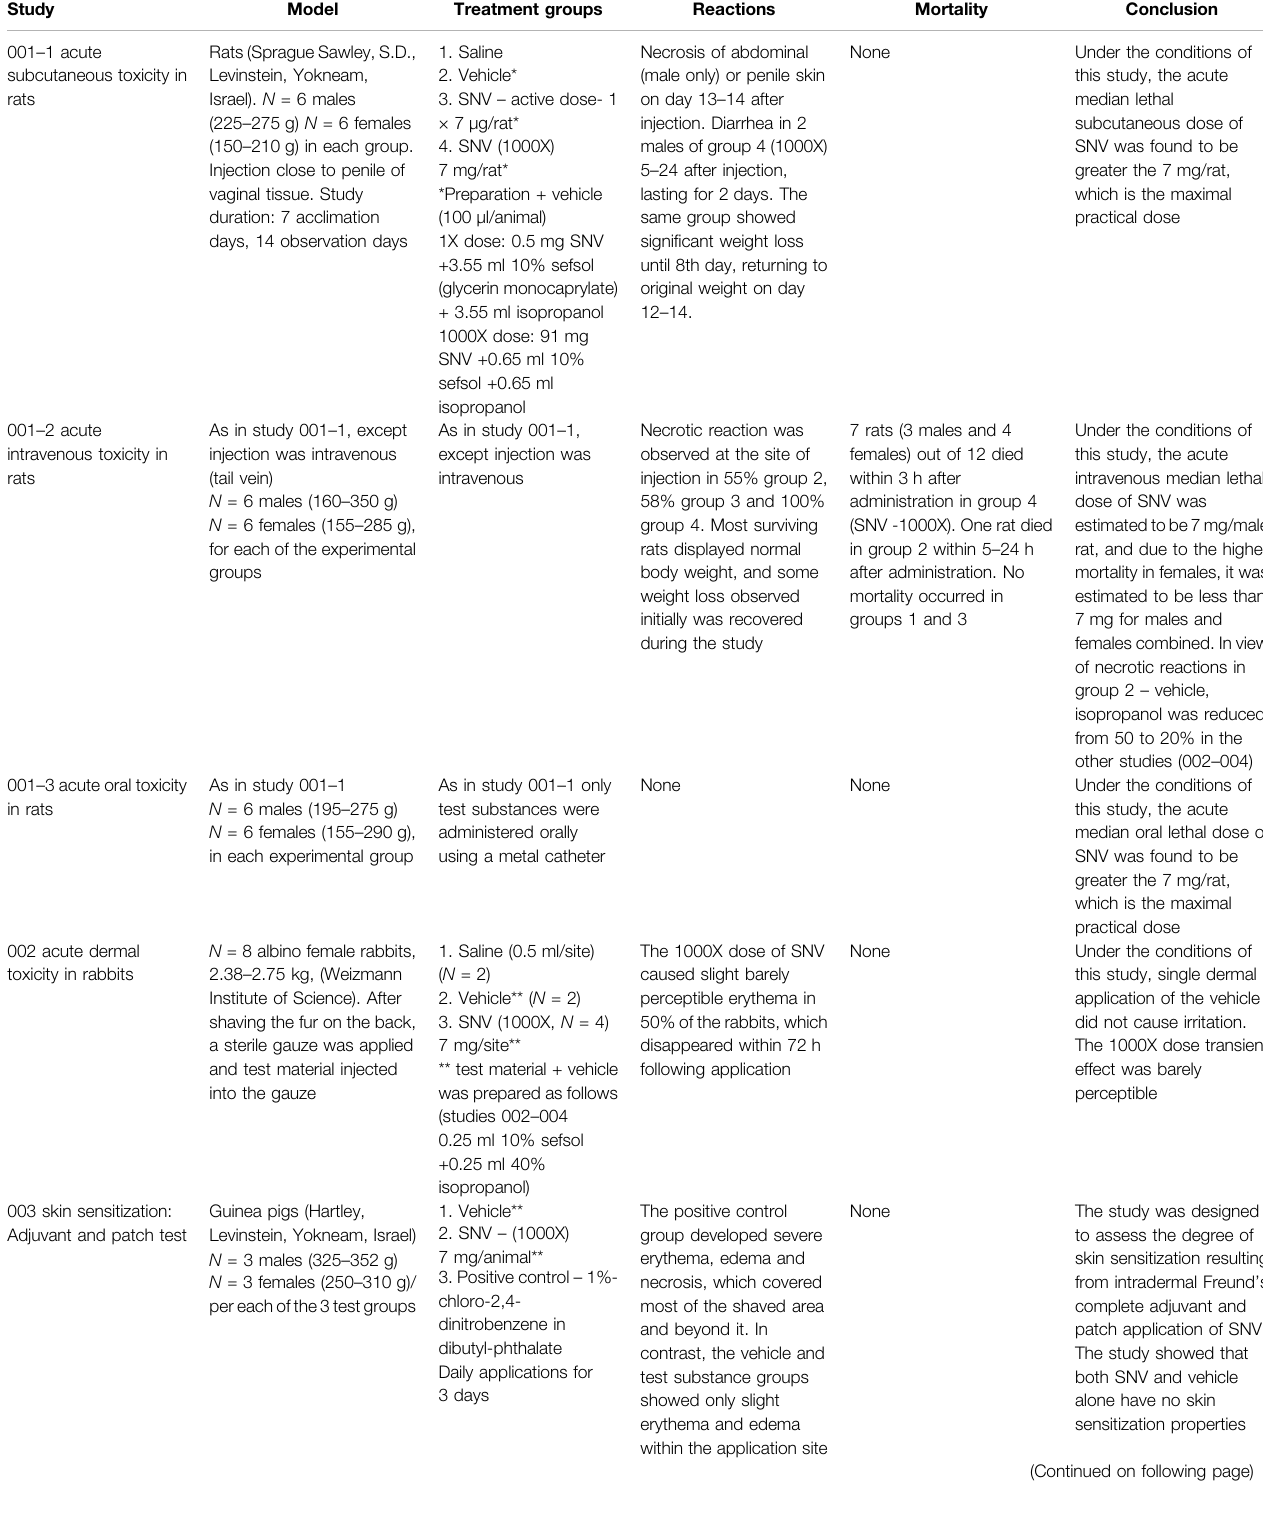
TABLE 1 | Toxicology